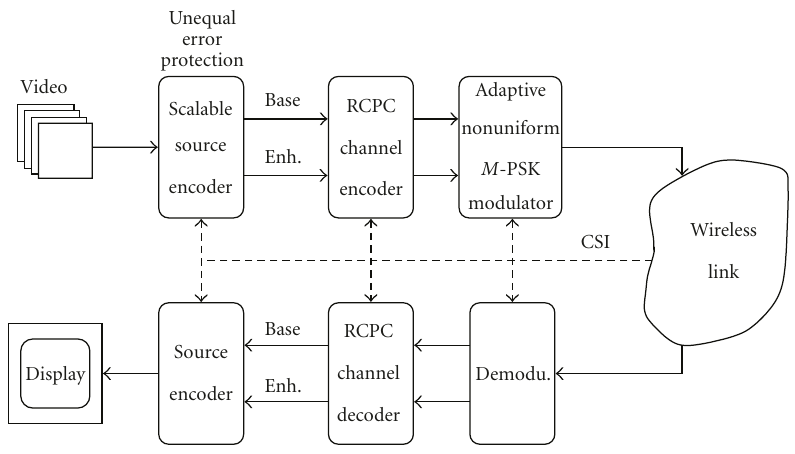
Figure 1: Illustration of a multilayered video coding and wireless delivery